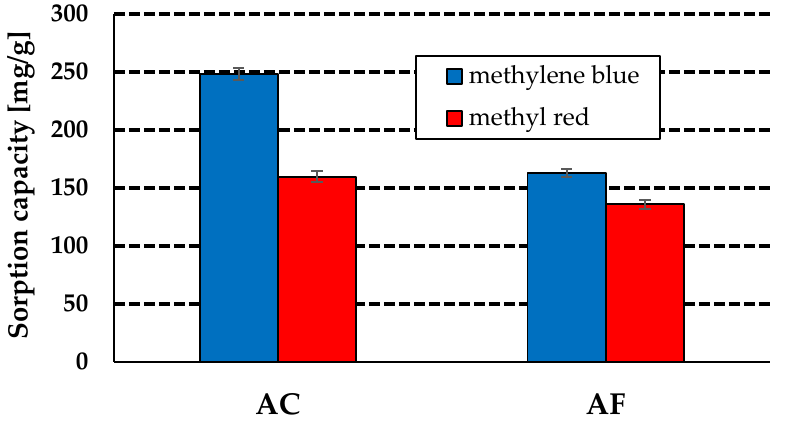
Figure 3. Sorption capacity of activated carbons towards aqueous solutions of methylene blue and methyl red.